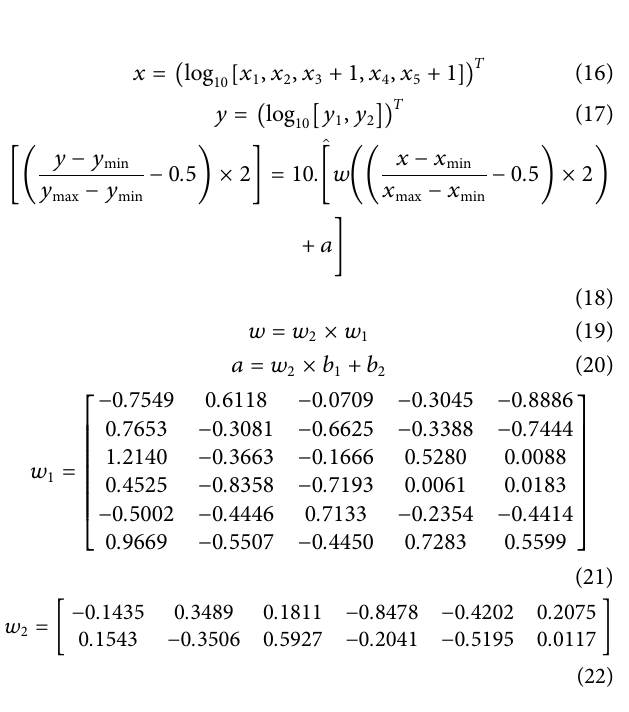
Frontiers in Materials |